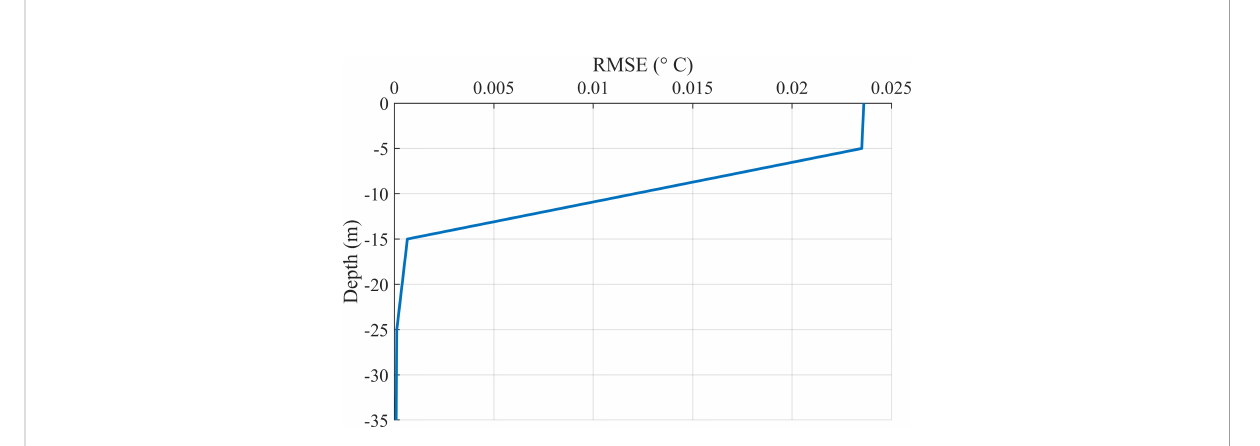
FIGURE 3 The vertical structure of the difference in RMSE of the temperature between the B_ ab and “ truth ” model simulation in